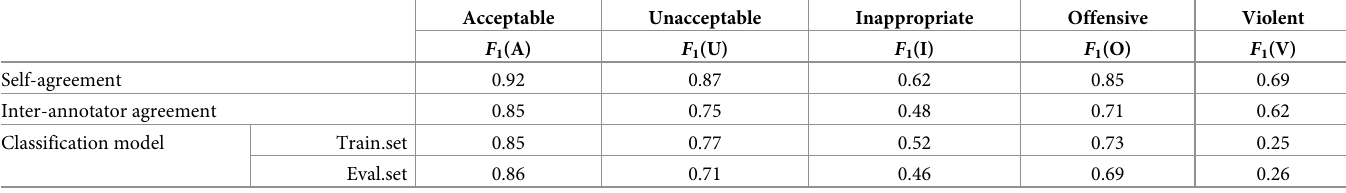
Table 4. The annotator agreement and the model performance for individual hate speech classes. The identification of individual classes is measured by the F 1 score. The lines correspond to Table 3. The last three columns give the F 1 scores for the three detailed hate speech classes which are merged into a more abstract, Unacceptable class ( F 1 (U)), used throughout the paper. Note relatively low model performance for the Violent class ( F 1